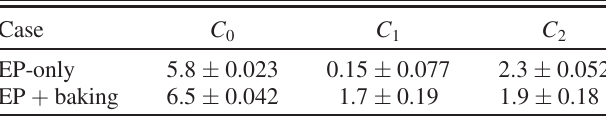
TABLE II. Second-order polynomial fitting results of the field- dependent R . s